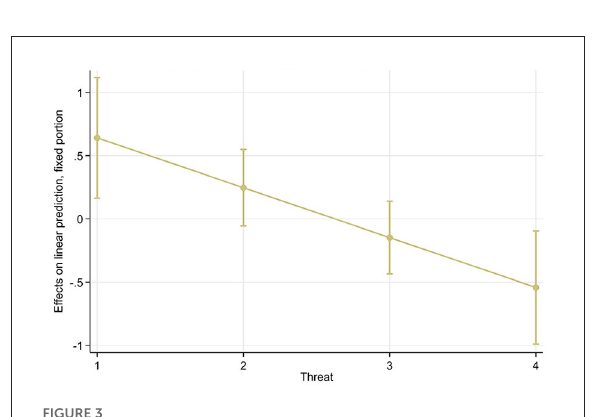
FIGURE3 Average marginal effects of the young man’s ethnicity, according to threat-level, with 95% confidence intervals.